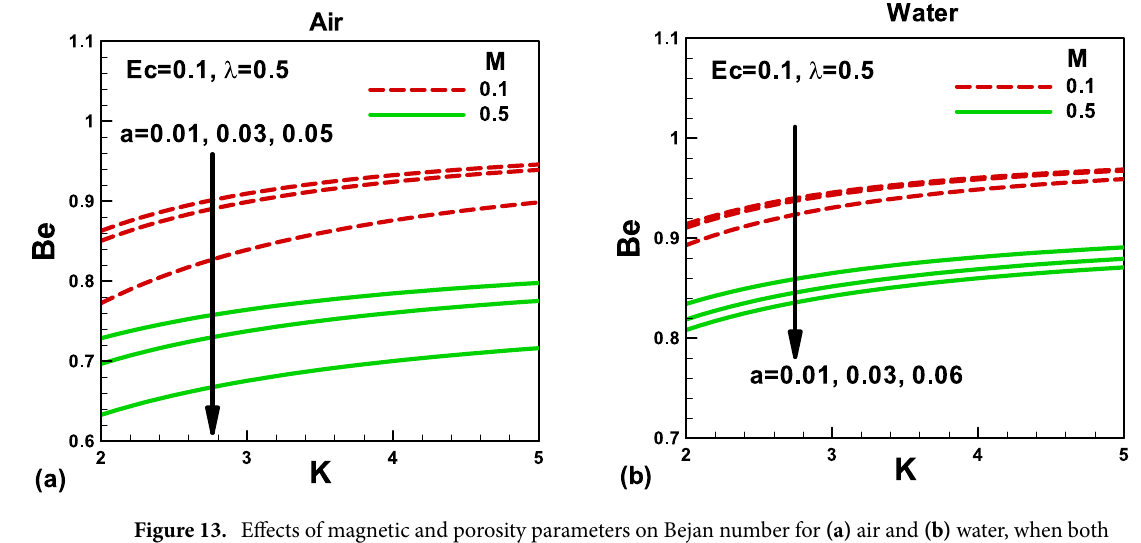
Figure 13. Effects of magnetic and porosity parameters on Bejan number for (a) air and (b) water, when both needle and fluid are moving in the same direction.